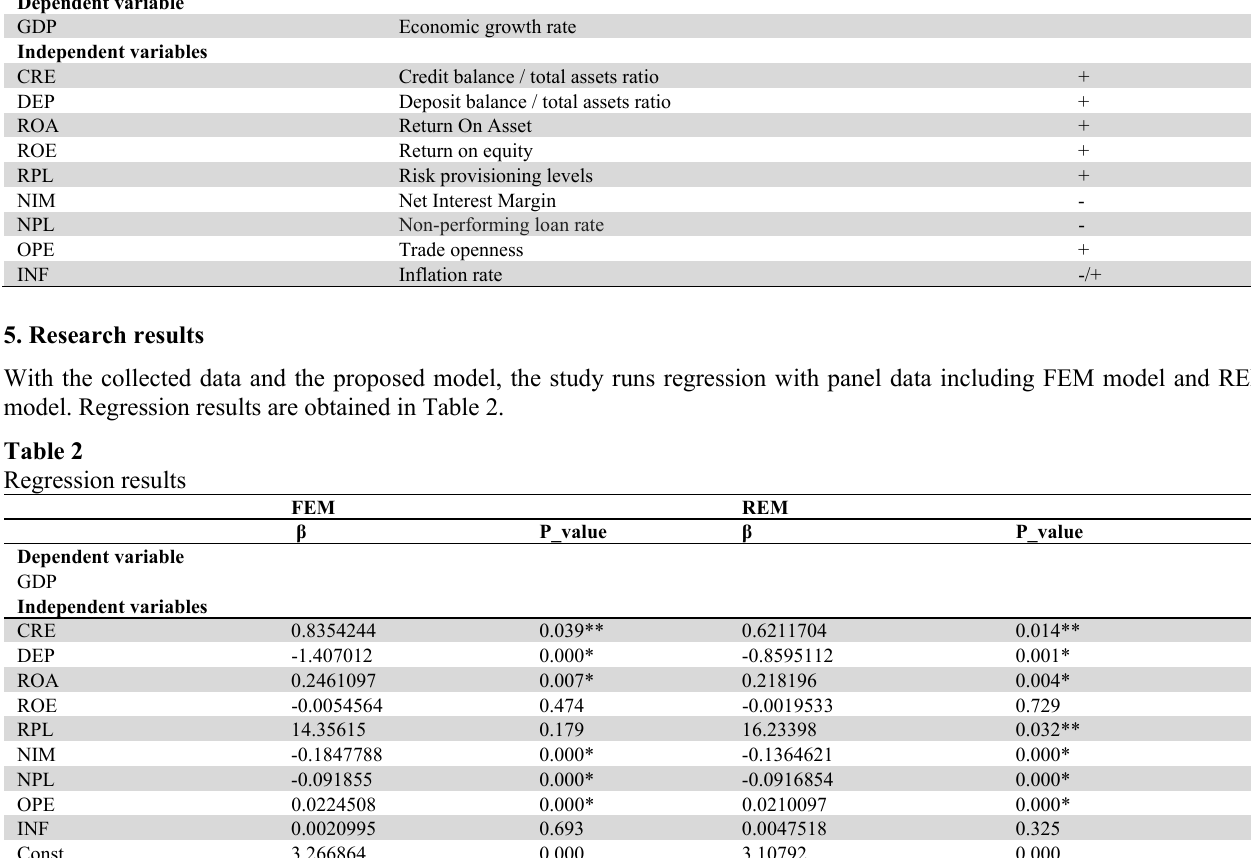
The meaning and expectation of variables in the research model No.